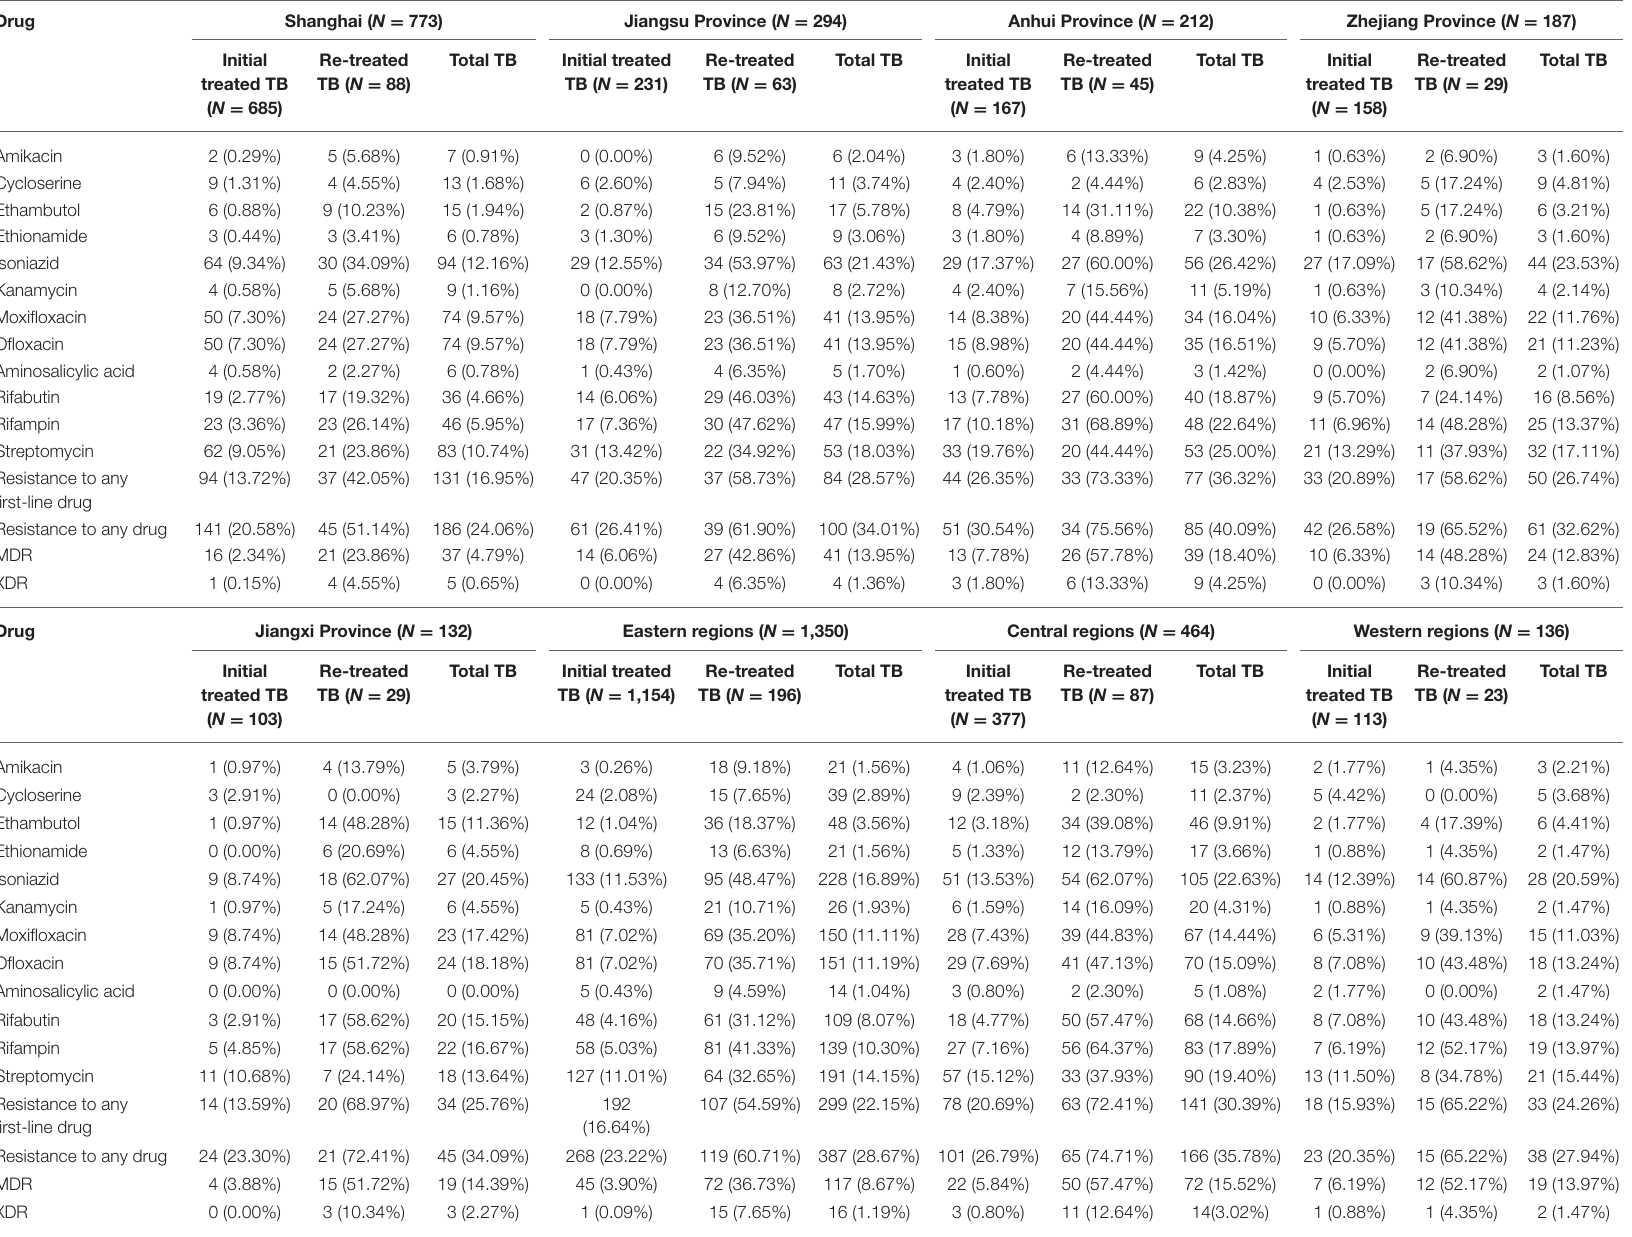
TABLE 4 | The drug resistance profile in different